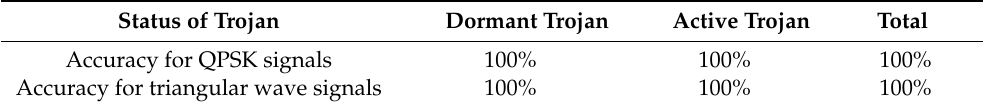
Table 4. Detection accuracy of the Trojan status. Status of Trojan Dormant